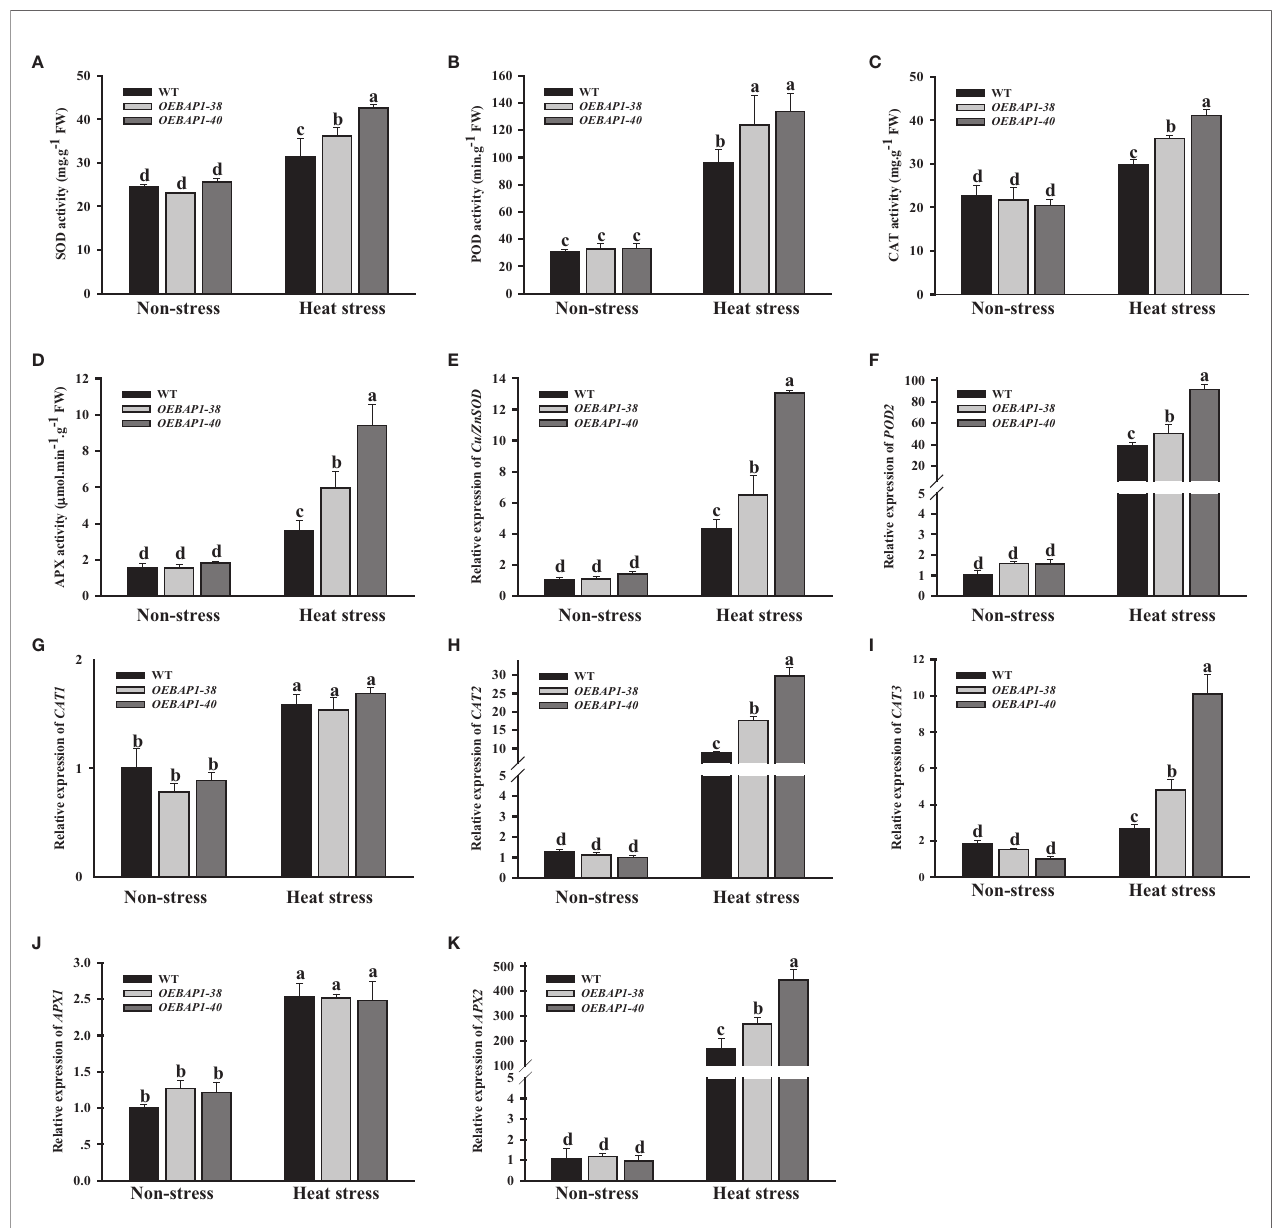
FIGURE 5 | Effects of heat stress on ROS-scavenging enzymes of VvBAP1 -overexpressing Arabidopsis leaves. The activity of CAT (A) , POD (B) , CAT (C) and APX (D) , the expression of SOD1 (E) , POD2 (F) , CAT1 (G) , CAT2 (H) , CAT3 (I) , APX1 (J) and APX2 (K) in the leaves of overexpressing lines under heat stress (45°C for 2 h). Each experiment was conducted thrice. Values are the means ± SE of three independent experiments ( P < 0.05). Lower-case letters above bars denote signi fi cant differences attested by Tukey ’ s HSD